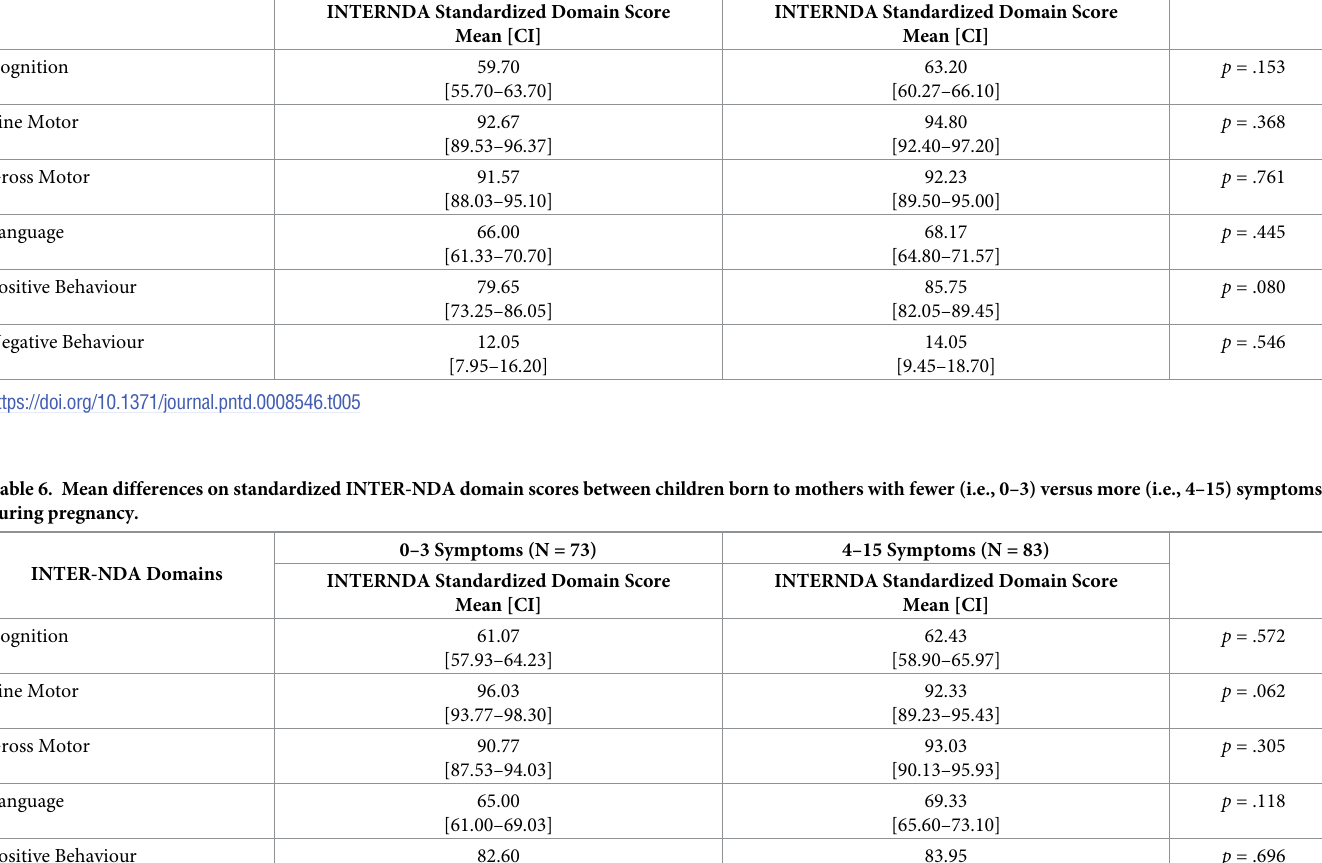
Table 5. Mean differences on standardized INTER-NDA domain scores between children born to mothers with short (0–7 days) and long (8–42+ days) symptom duration during pregnancy. INTER-NDA Domains